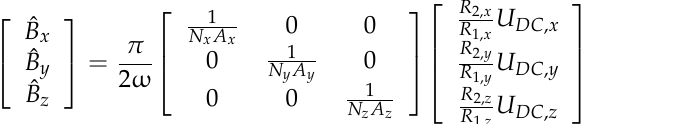
Figure 17. Bode plot of the search coil transfer function. 3.2. Voltage Conversion Error of the Search Coil Magnetometer As described in [16], the error of the magnetic field to voltage conversion can be ex- pressed with noise equivalent magnetic induction (NEMI). NEMI is defined as the output voltage noise of the search coil magnetometer in relation to the transfer function of the